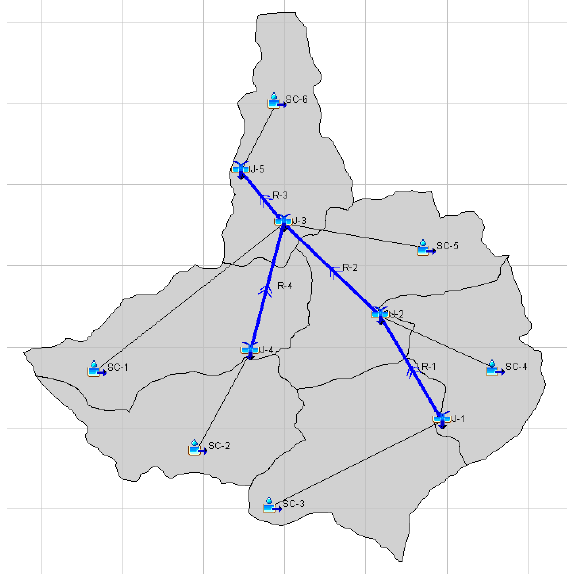
Figure 2. The schematic model of the Upper Skawa Catchment created in HEC-HMS. The names of sub-catchments, junctions and reaches are abbreviated with SC, J, and R, respectively.